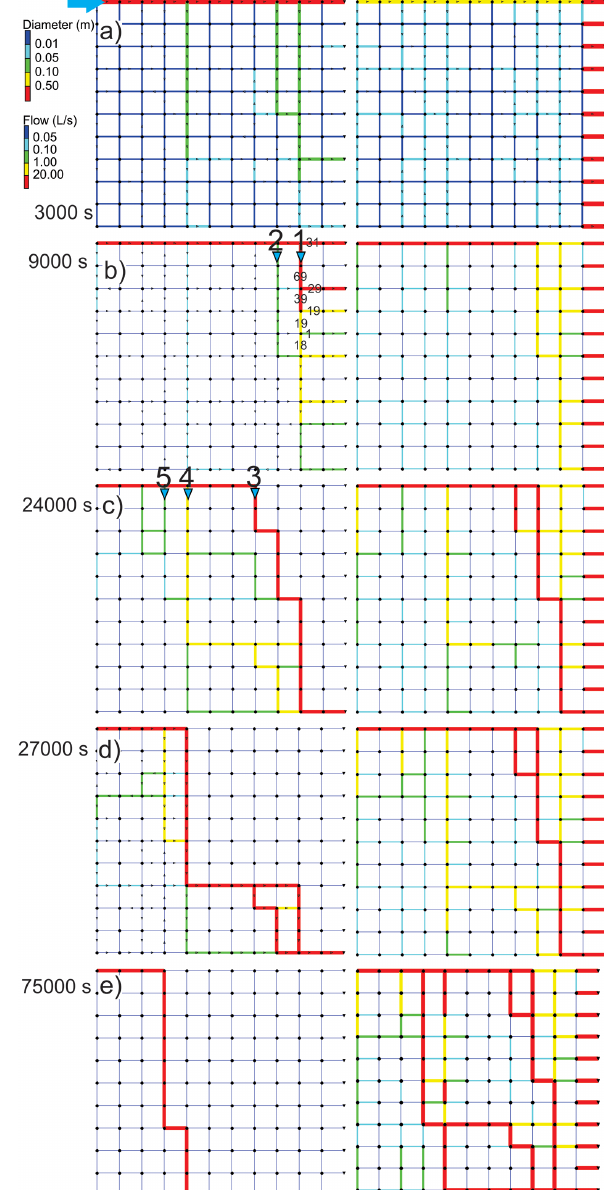
Figure 18. High-dip network with random initial distribution of conduit diameters. Flow enters at the top-left edge of the network as pointed by a blue arrow. Values on (b) show flow rates along the selected individual